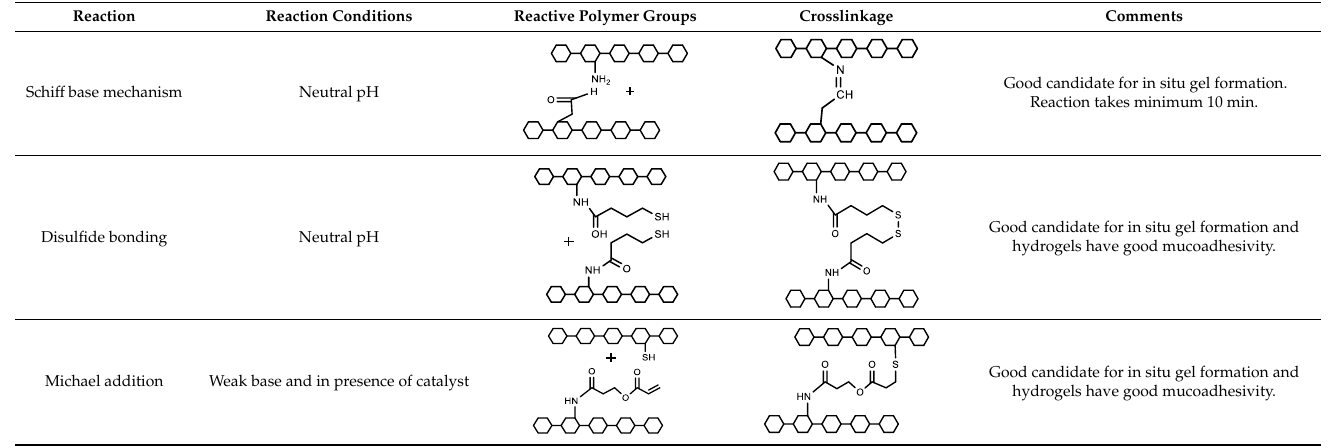
Table 2. Crosslinking of polymers through reactive functional groups.